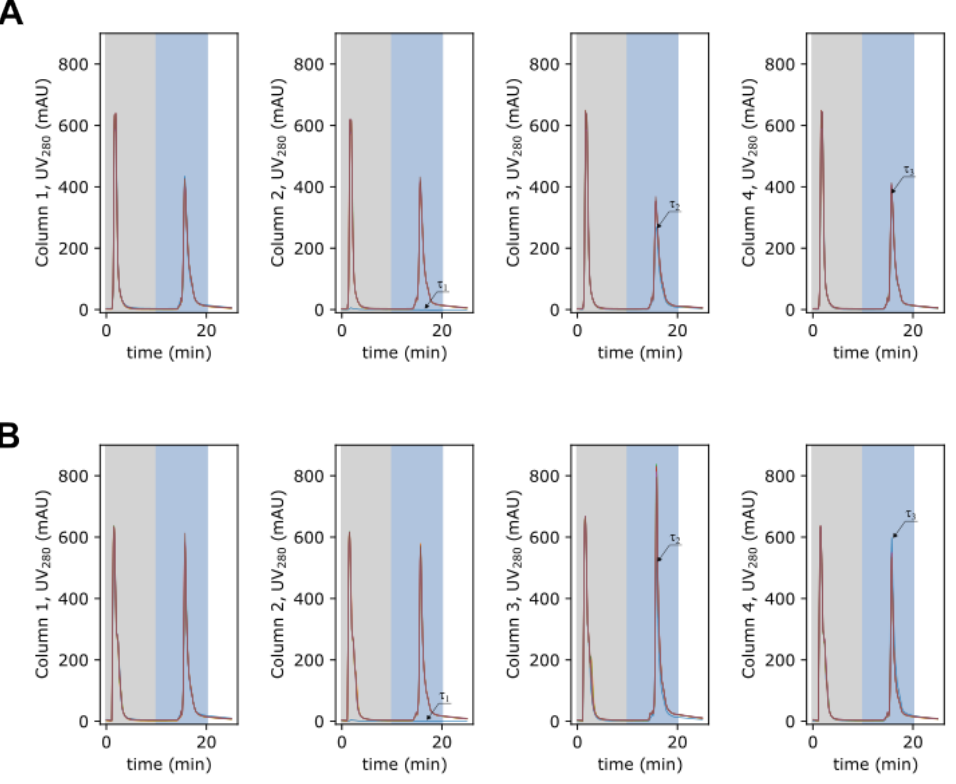
Figure 5. Chromatograms of PCC: run 1 ( A ) and run 2 ( B ); detail of the initial 25 min of each switching interval. The gray zone marks column wash and light blue marks